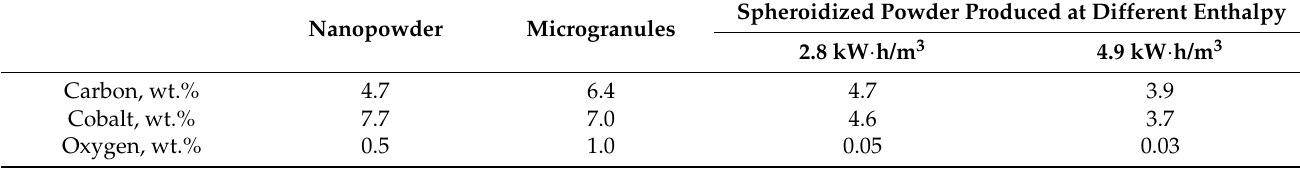
Table 2. Composition of powders